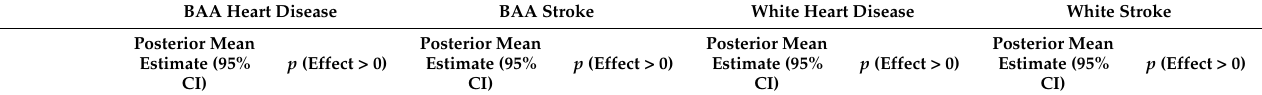
Table 4. Estimated posterior mean change in the effect of AHM non-adherence on the average log rate of heart disease and stroke for Black/African Americans and non-Hispanic Whites for a standard deviation increase of 1 in each covariate among 875 counties in the